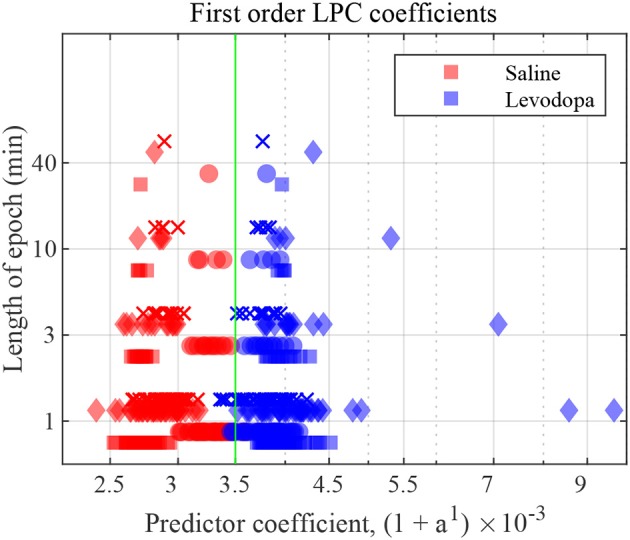
First order LFP coefficients for dopamine-depleted mice following injection with saline (red) or levodopa (blue). Entire 40-min data set was divided into epochs of lengths 1, 3, 10 and 40 min. Y axis represents length of each epoch, and X axis the value of the coefficient a1 plotted as (1 + a1) × 10−3. Each symbol represents a single coefficient from a single epoch. Squares are data from mouse 1, circles mouse 2, diamonds mouse 3, and crosses mouse 4. The threshold (green) is calculated by taking the average of the minimum value in levodopa session and the maximum value in saline session for 40 min epochs.